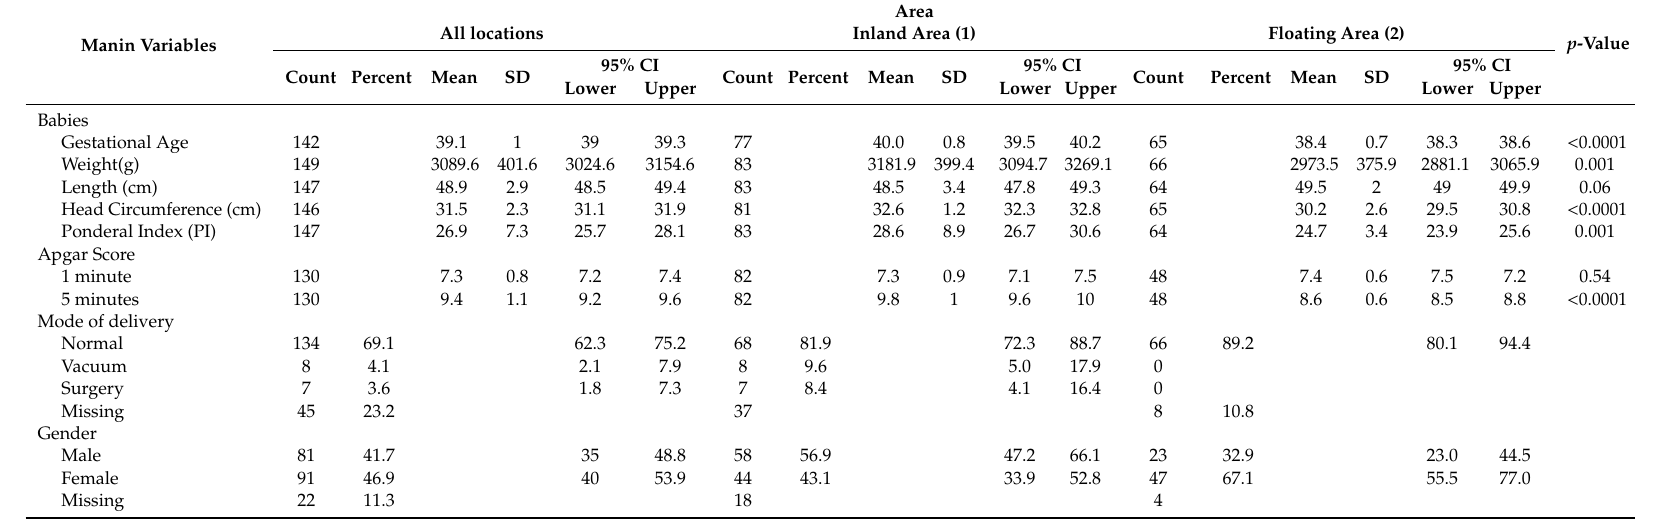
Table 2. Demographic information on the newborns included in the